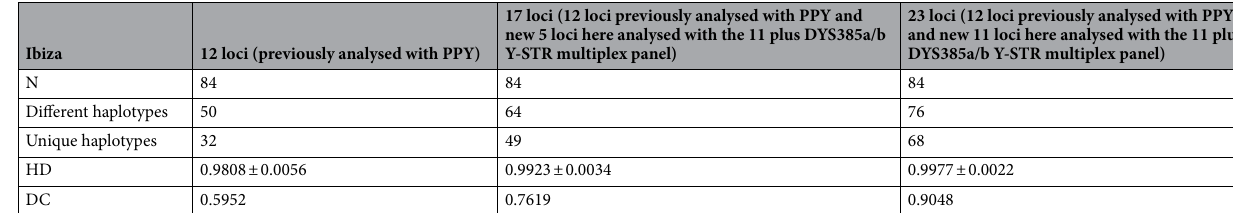
Table 1. Diversity parameters obtained for the population analyzed considering 12, 17 and 23 loci. N sample size, HD haplotype diversity, DC discriminatory